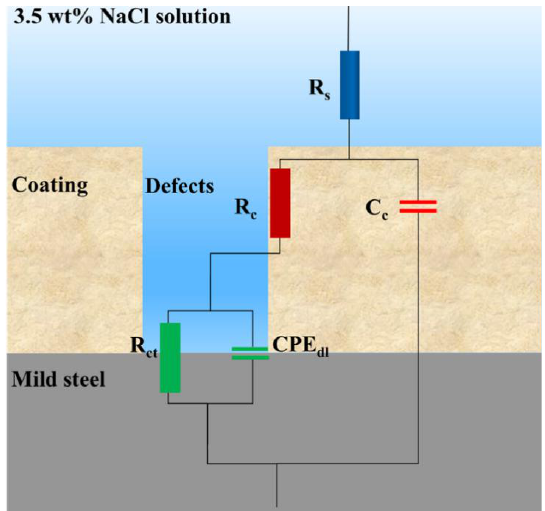
Figure 3. Equivalent circuit for EIS data fitting.